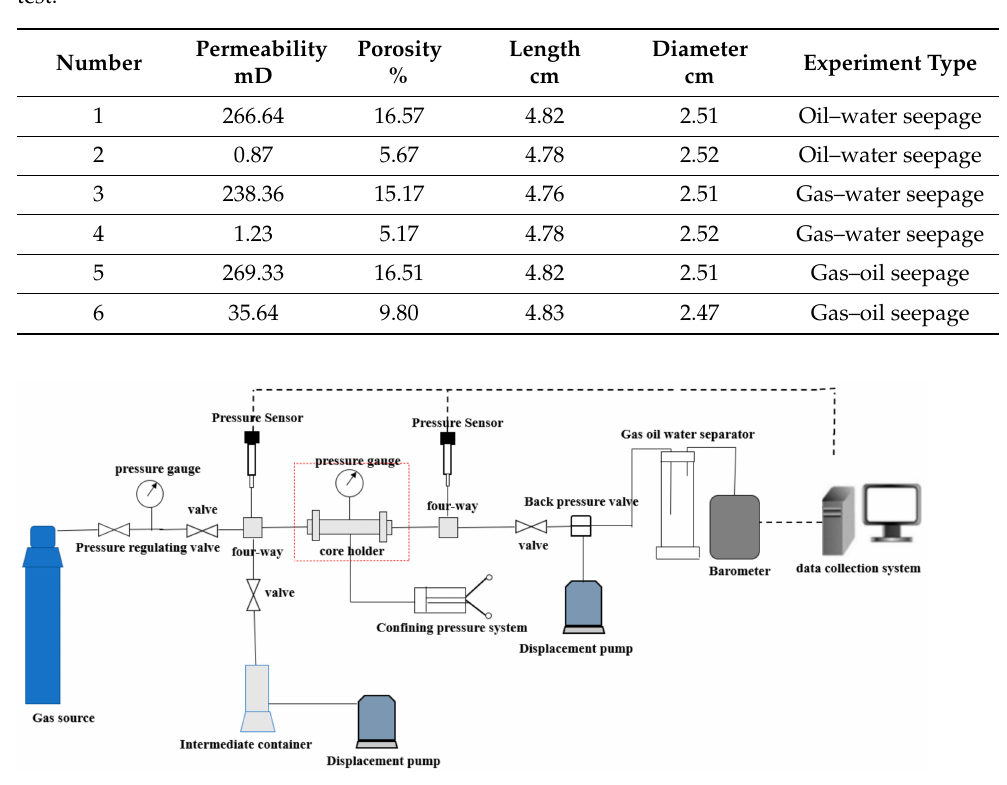
Table 1. Basic physical properties and classification of experimental cores for relative permeability test.